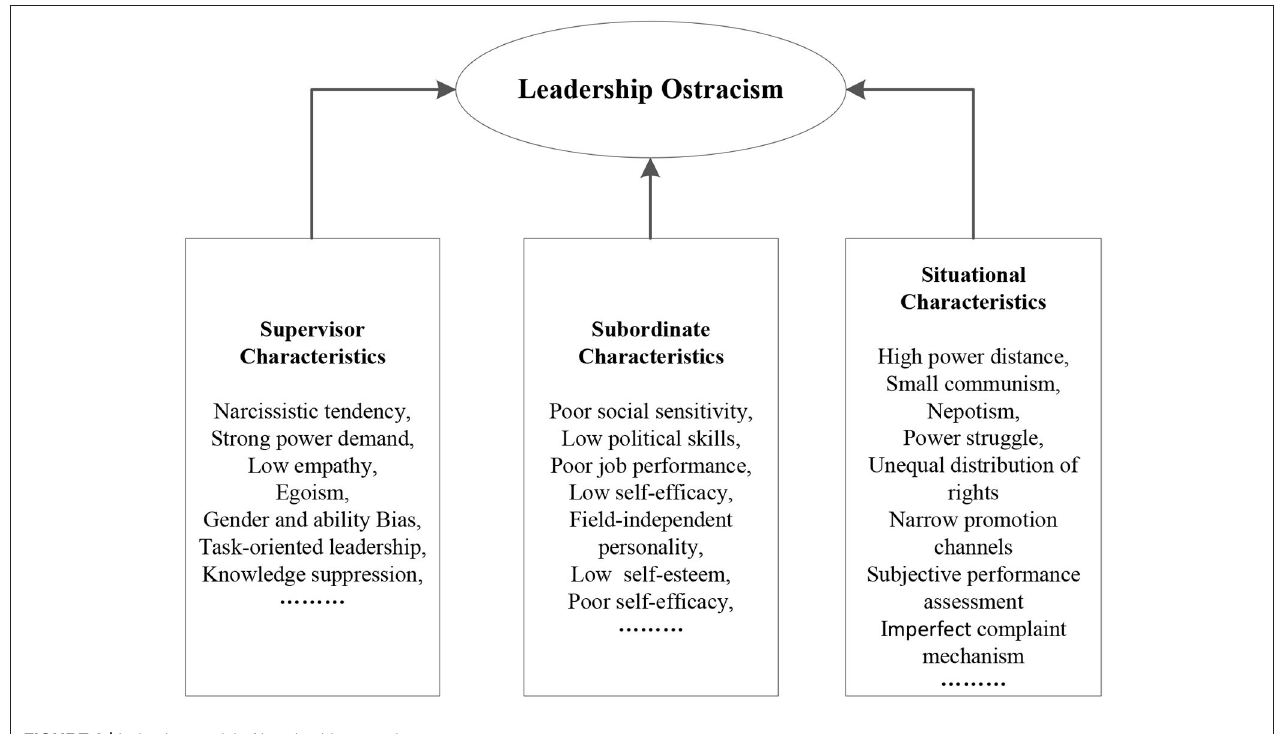
FIGURE 3 | Inductive model of Leadership ostracism.